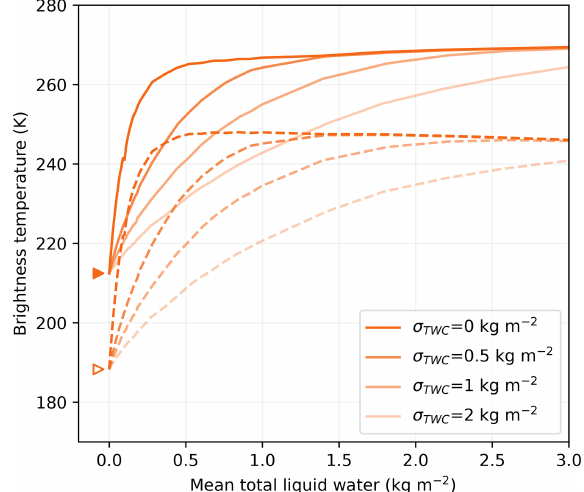
Figure 7. Brightness temperatures as a function of the total liquid water content at 19GHz at V-pol (solid curves) and H-pol (dashed curves) at Roi Baudouin when the liquid water content is hetero- geneous. σ TWC is the standard deviation of the normal distribution used to generate local total liquid water content (negative values set to